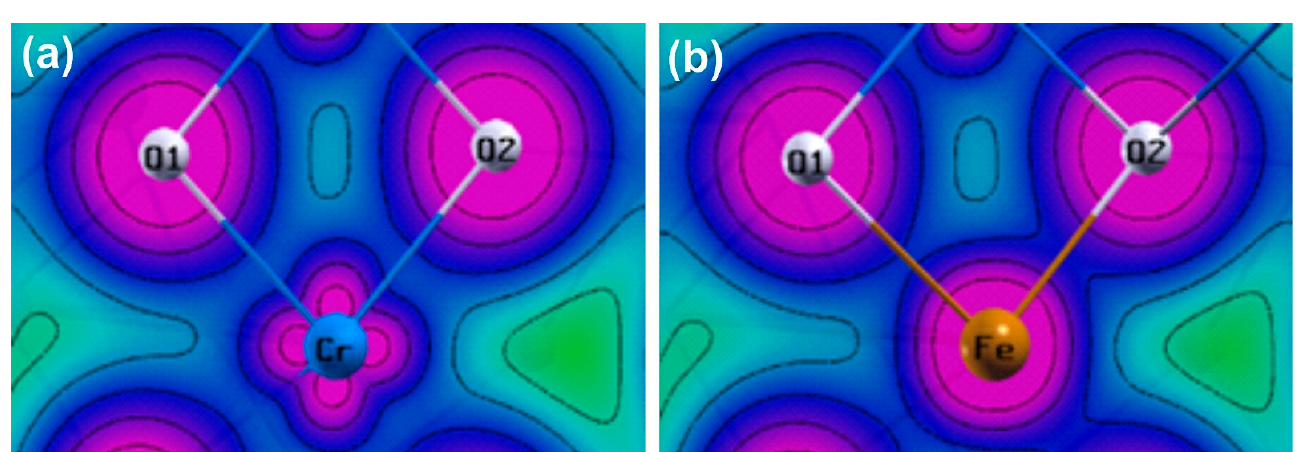
Figure 5. ( a ) Total valence electron density of Cr 2 O 3 and ( b ) Fe-doped Cr 2 O 3 crystals generated in the crystal plane through Cr and Fe ions to evidence the chemical bonding changes of the corresponding local structures. Produced using Xcrysden software [89].